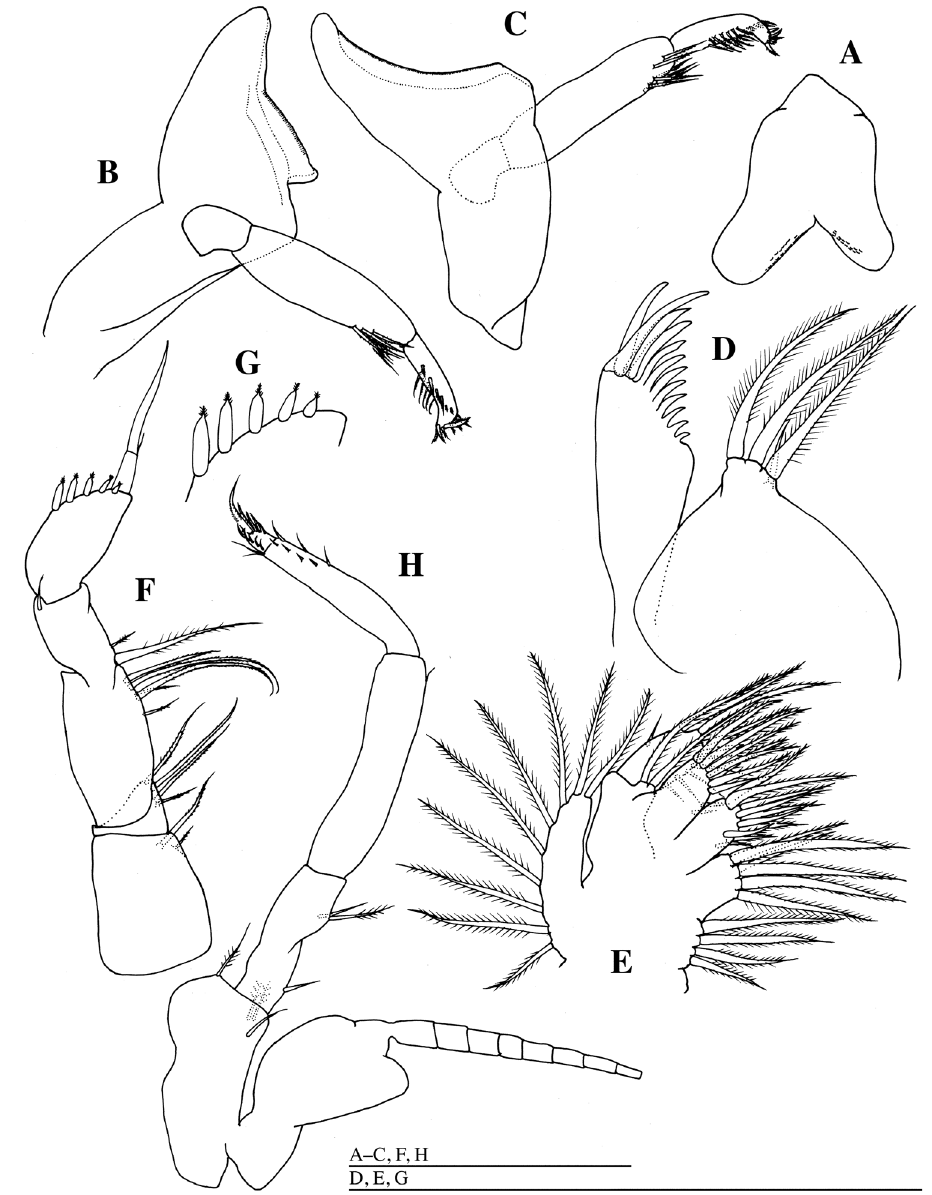
Figure 3. Mysidella hoshinoi sp. n., holotype male: A labrum ventral B left mandible, dorsal C right mandible, ventral D left maxillula, dorsal E left maxilla, dorsal F right first thoracopod, dorsal G peculiar spines on outer margin of carpopropodus of endopod of first thoracopod H right second thoracopod, lateral. Scale bars: 500